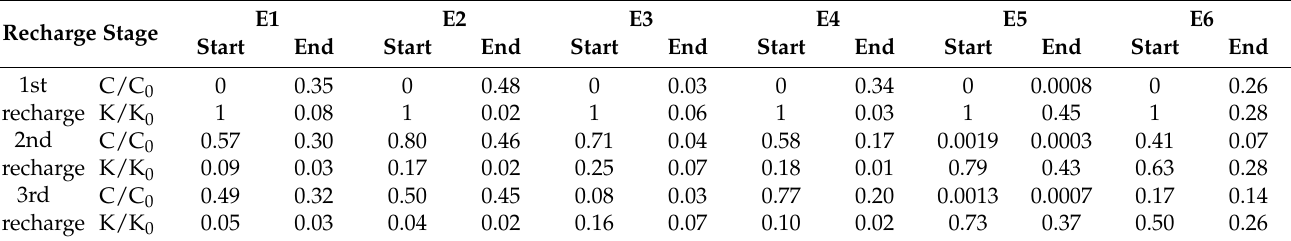
Figure 4. Clogging effect of background water. Table 5. Corresponding characteristic values of C/C 0 and K/K 0 .